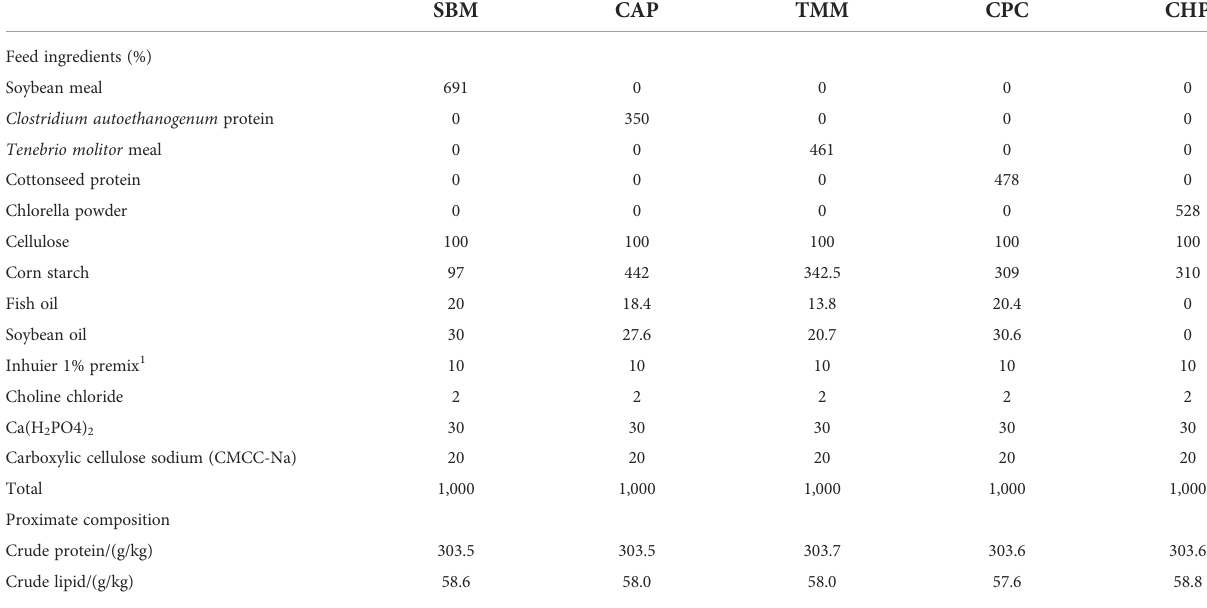
TABLE 1 Ingredients and proximate composition of experimental diet. Feed ingredients (%)